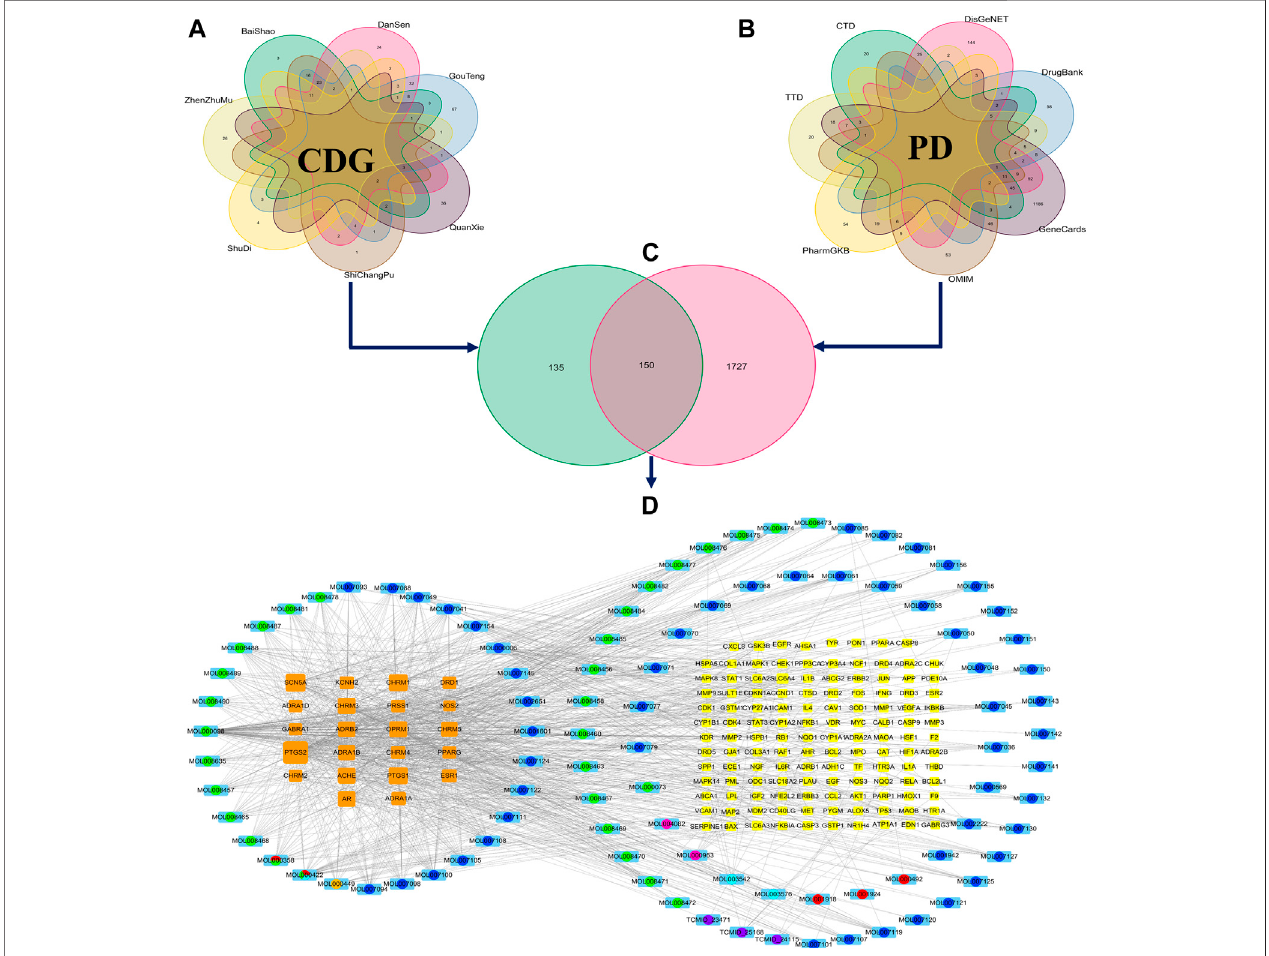
FIGURE1| Theconstructionoftheingredient-targetnetworkofCDG. (A) ThecollectionofthetargetsofCDG. (B) ThecollectionoftherelatedgenesofPD. (C) The intersection of CDG targets and PD-related genes. (D) The ingredient-target network of CDG. The yellow and orange squares represent targets. Big size represents the largerDegreeCentrality;thecoloredcirclewithskybluesquarebackgroundrepresentstheingredientsfromdifferentherbs.Circleswithdifferentcolorsectorsrepresent the ingredients from multiherbs.